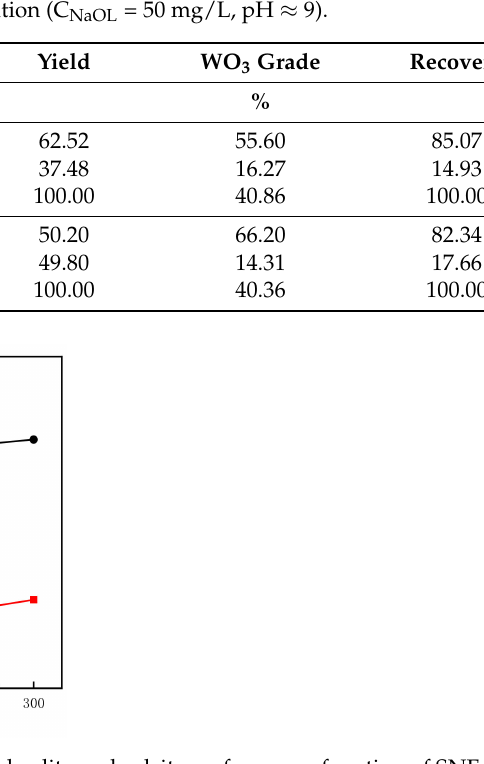
Figure 6. Adsorption amounts of SNF on scheelite and calcite surfaces as a function of SNF dosage at pH 9.